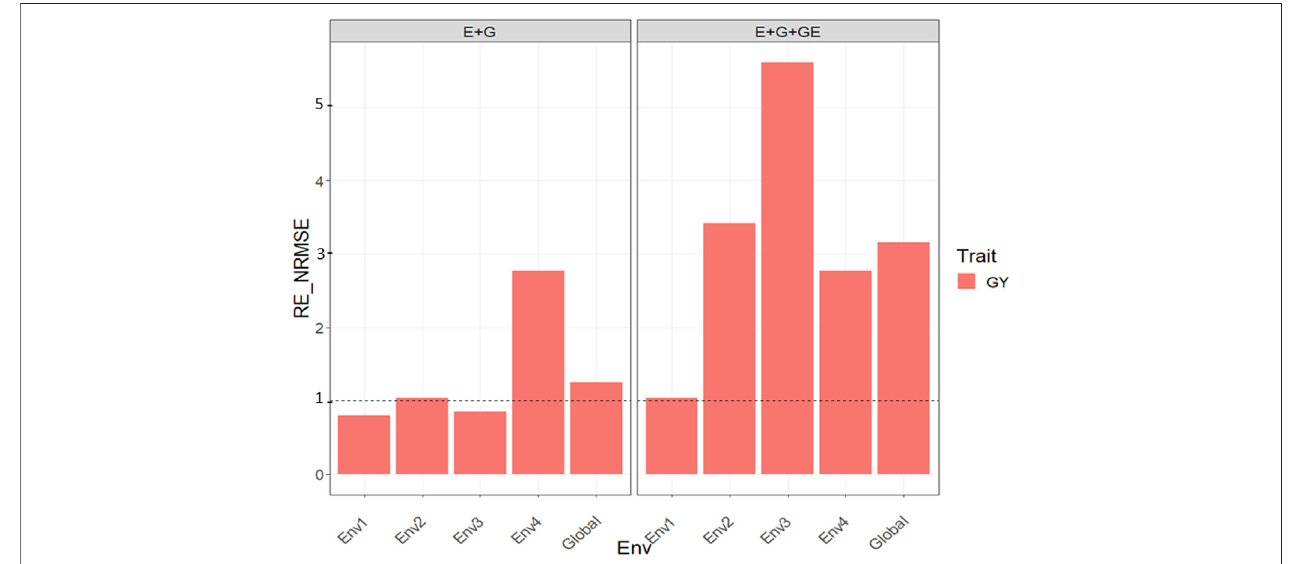
FIGURE 5 | Relative ef fi ciency in terms of normalized root mean square error (RE_NRMSE) computed by dividing the NRMSE under the best linear unbiased predictor model (GBLUP) between the NRMSE of the partial least squares regression method. Prediction performance is reported for each environment and across environments (Global) in dataset 5 (Maize), also with twopredictors (E + Gand E +G + GE). When the RE_NRMSE > 1 the PLS outperforms the GBLUP method in terms of prediction performance (lower NRMSE).